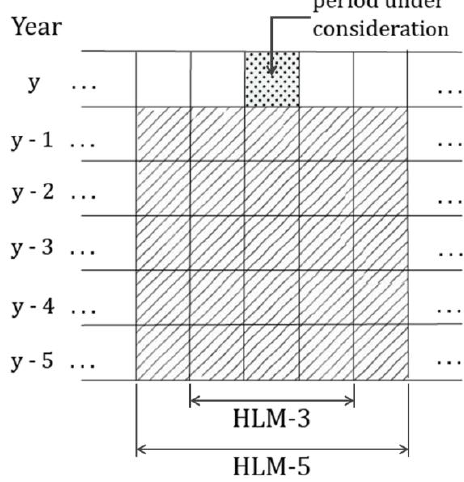
Figure 3. Historical data of the historical limits methods (HLM). HLM-3 = 3 consecutive weeks in the historical data, HLM-5 = 5 consecutive weeks in the historical data.